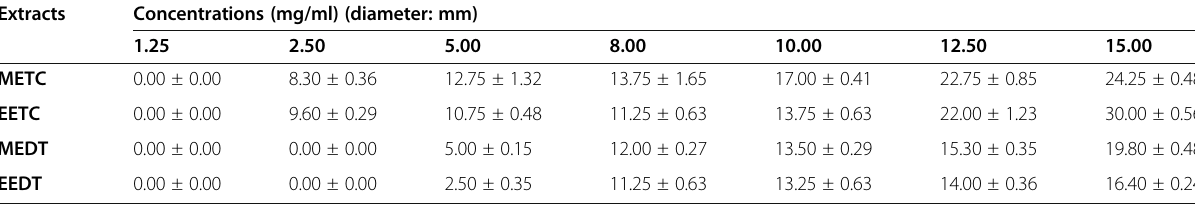
Table 4 Zone of inhibition in diameter (mm) of different alcoholic extracts of Terminalia citrina (Roxb.) fruits and Desmodium triflorum (L.) whole plant